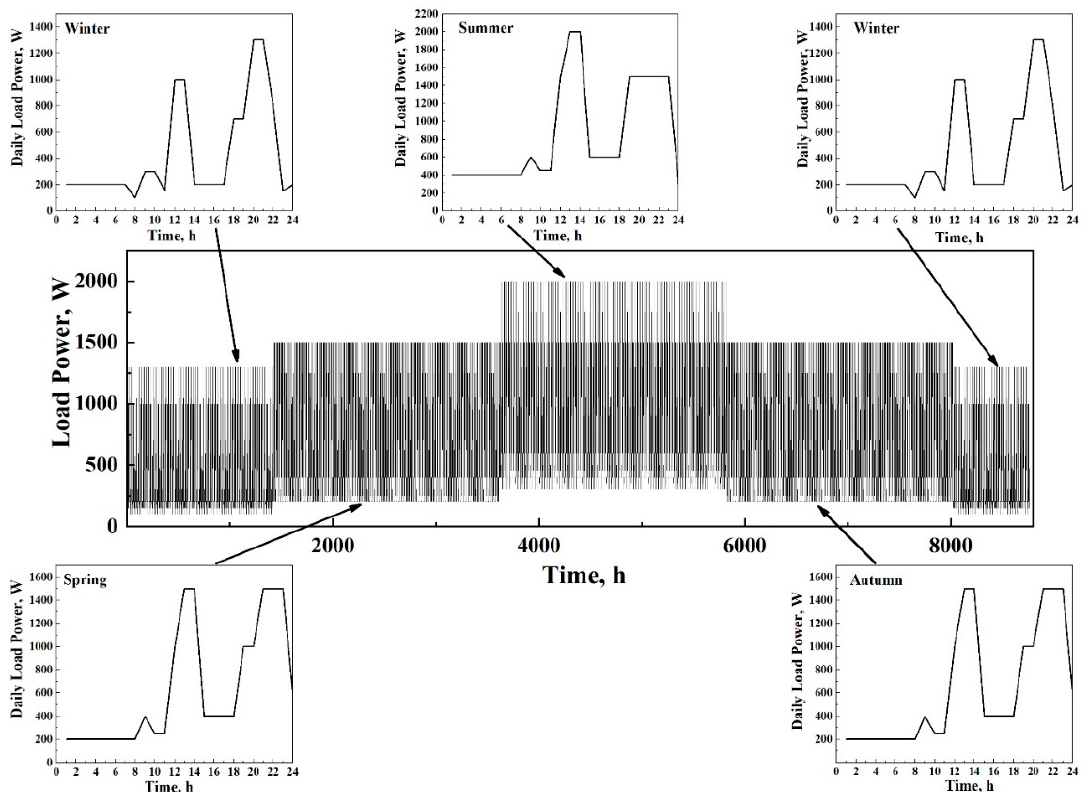
Figure 4. Hourly sequence of the annual load profile, based on the daily electrical appliance usage from a four-person household.